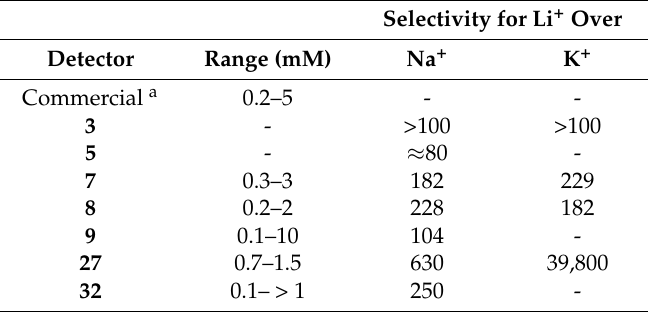
Table 1. Selectivity data for selected Li + -responsive systems.